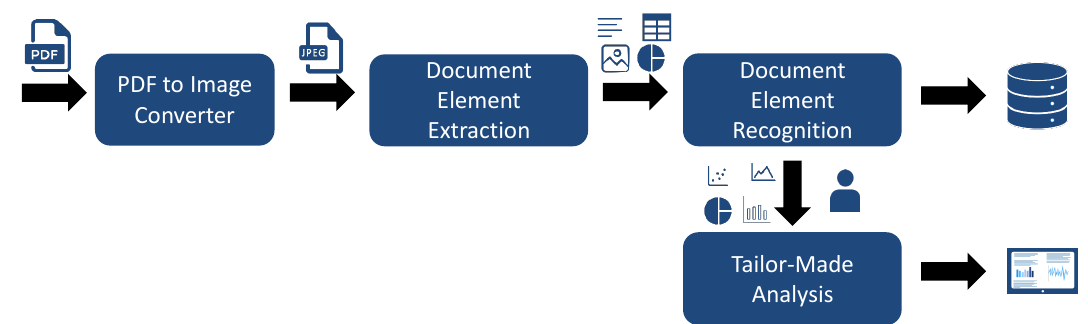
Figure 1. The pipeline that we use for processing PDF documents. First, each PDF document is converted into an image. Second, we extract the relevant document elements, such as figures, tables or algorithms. After detecting the different document elements, they have to be further classified and analyzed. After this additional information is extracted and recognized, we store it in a database and forward it to the data scientists. The results from the document element recognition are then used by data scientists for further analysis and